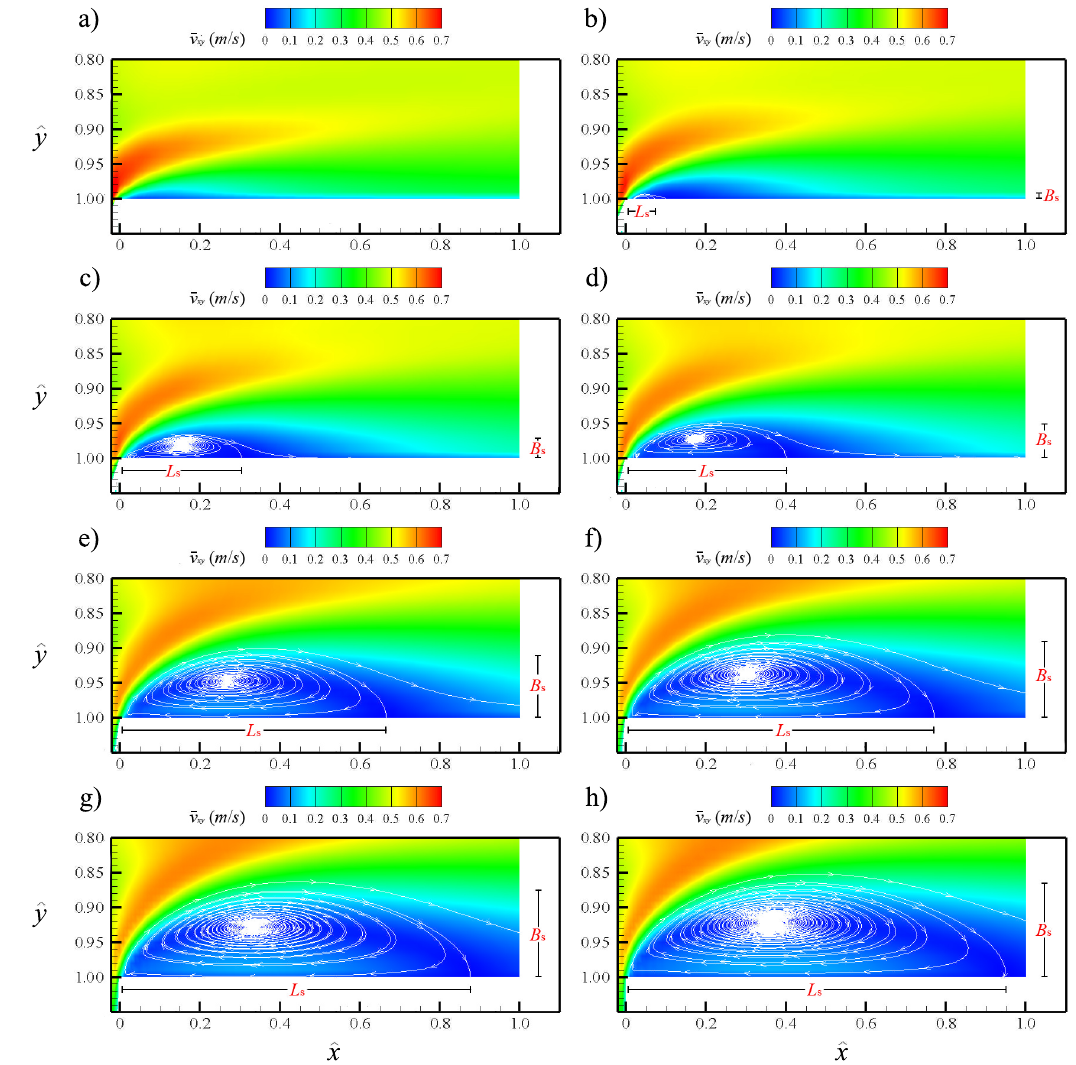
Figure 15. Time-averaged velocity ¯ v xy in the horizontal plane ˆ z ∼ 0.5 for α equal to: ( a ) 50 ◦ ; ( b ) 55 ◦ ; ( c ) 60 ◦ ; ( d ) 65 ◦ ; ( e ) 75 ◦ ; ( f ) 80 ◦ ; ( g ) 85 ◦ ; ( h ) 90 ◦ . Here, ˆ x = x / B m is the non-dimensional abscissa directed in the streamwise direction centred in the downstream corner of the